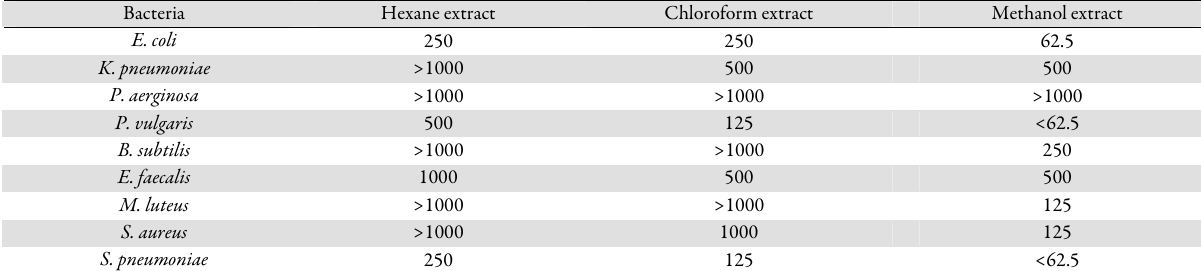
Tab. 2. MIC values of the L. acidissima